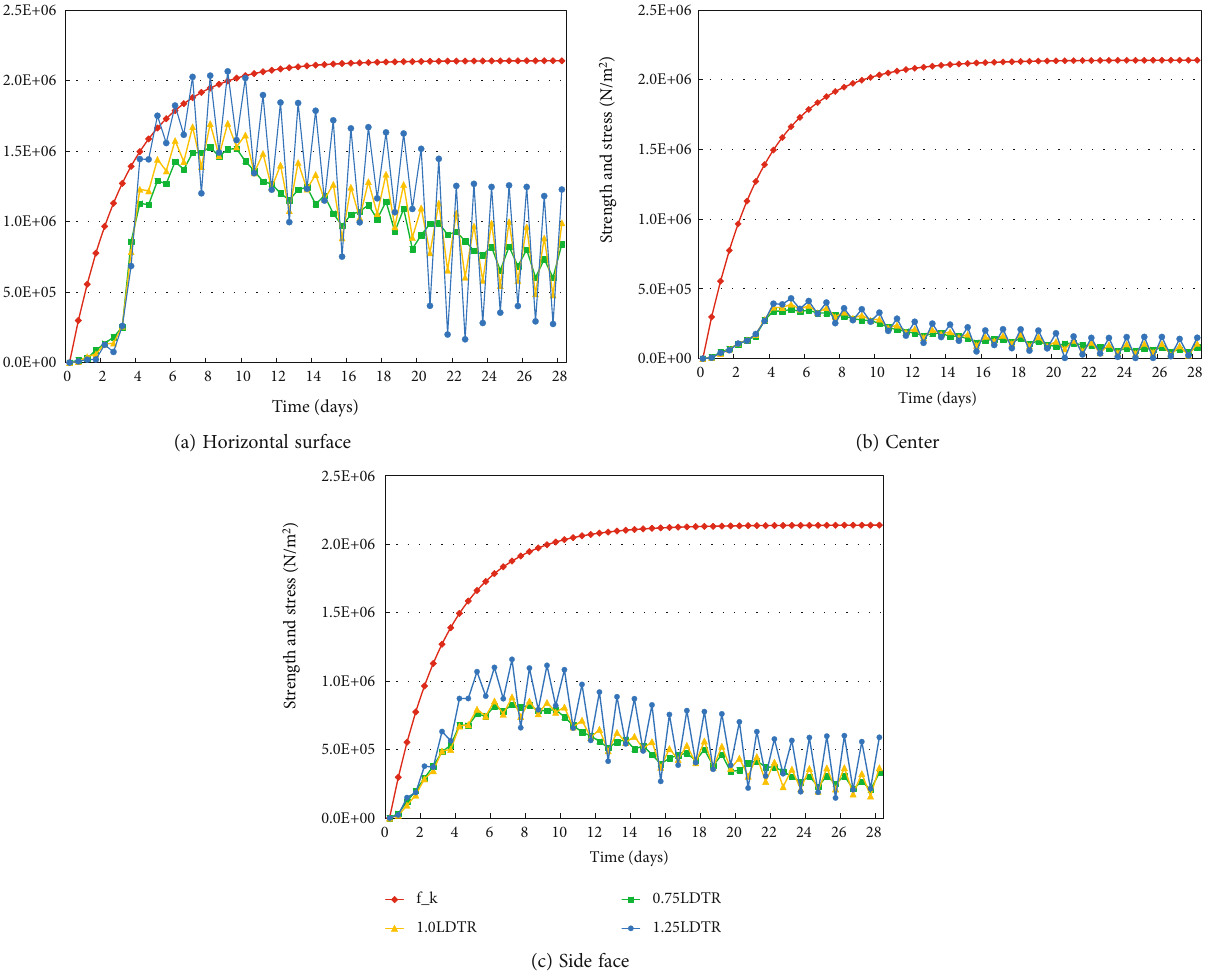
Figure 10: Maximum temperature stresses of concrete under di ff erent